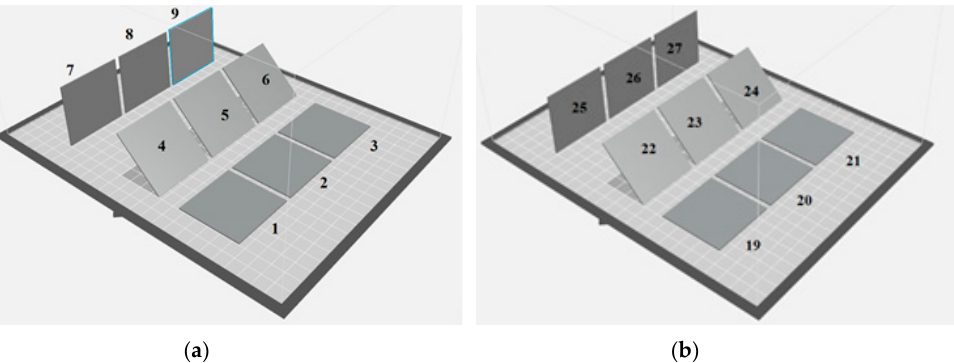
Figure 3. Overview of samples orientation on the build platform prepared for FFF process: ( a ) samples 1–9, ( b ) samples 19–27.